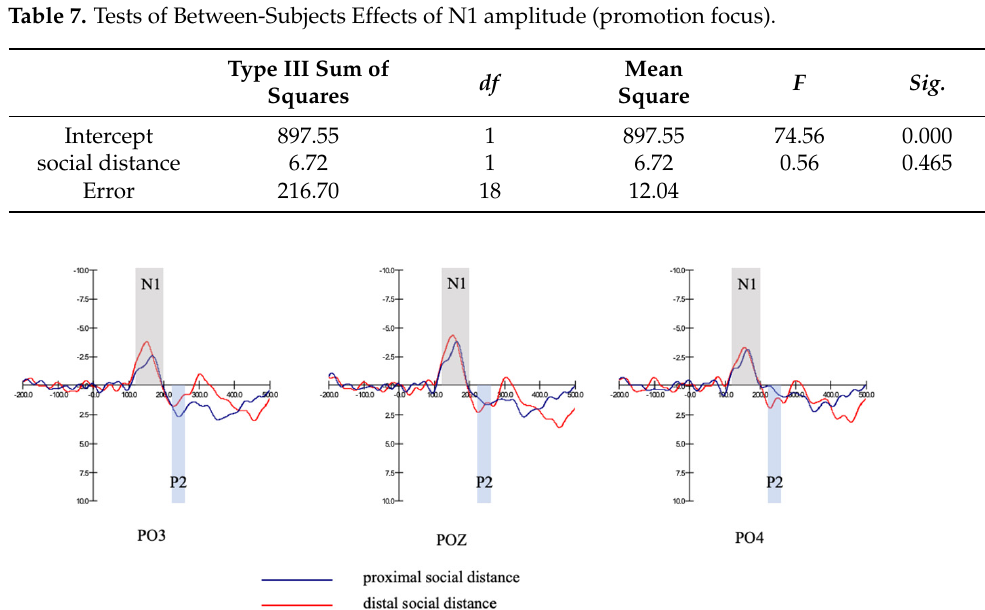
Table 7. Tests of Between ‐ Subjects Effects of N1 amplitude (promotion focus).